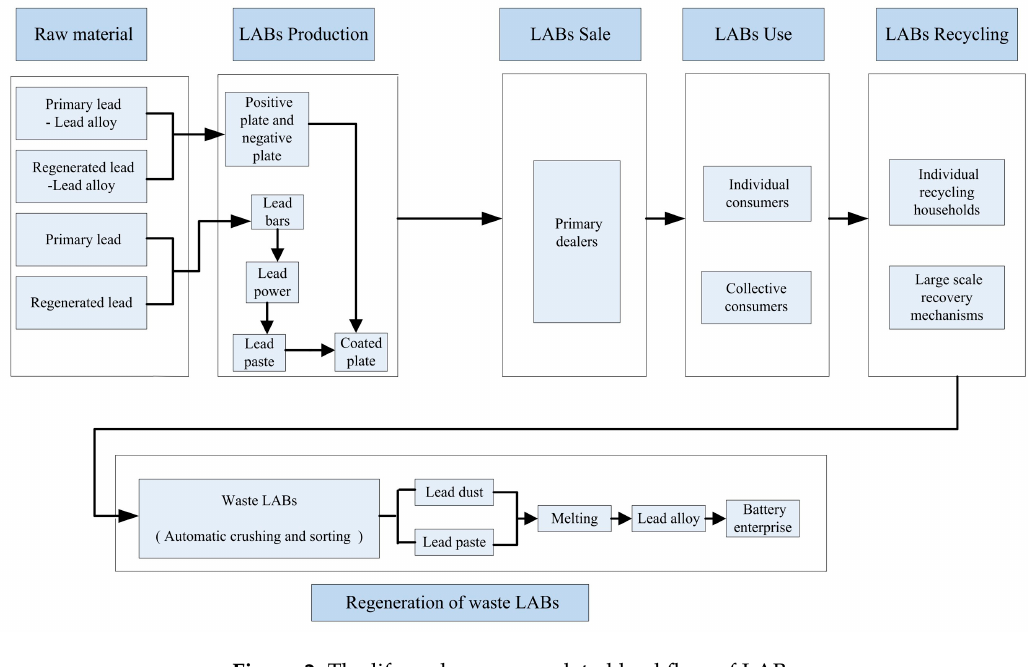
Figure 2. The life cycle process-related lead flow of LABs.